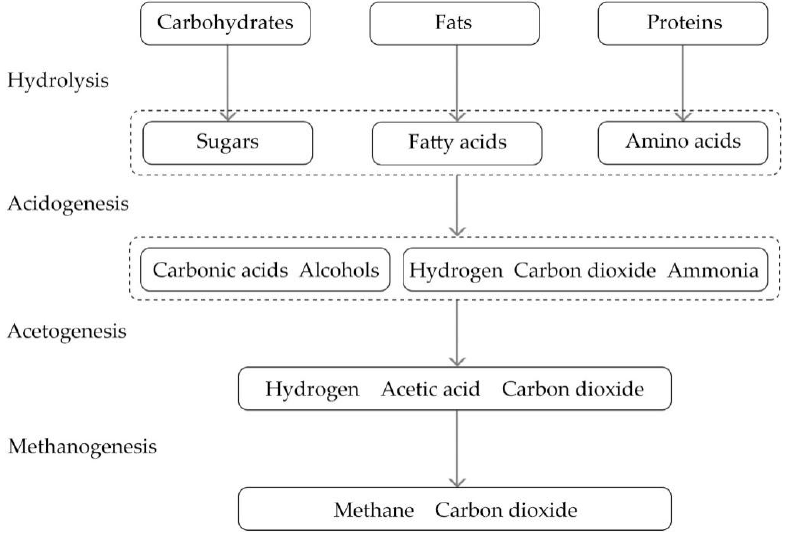
Figure 13. Stage pf anaerobic digestion.